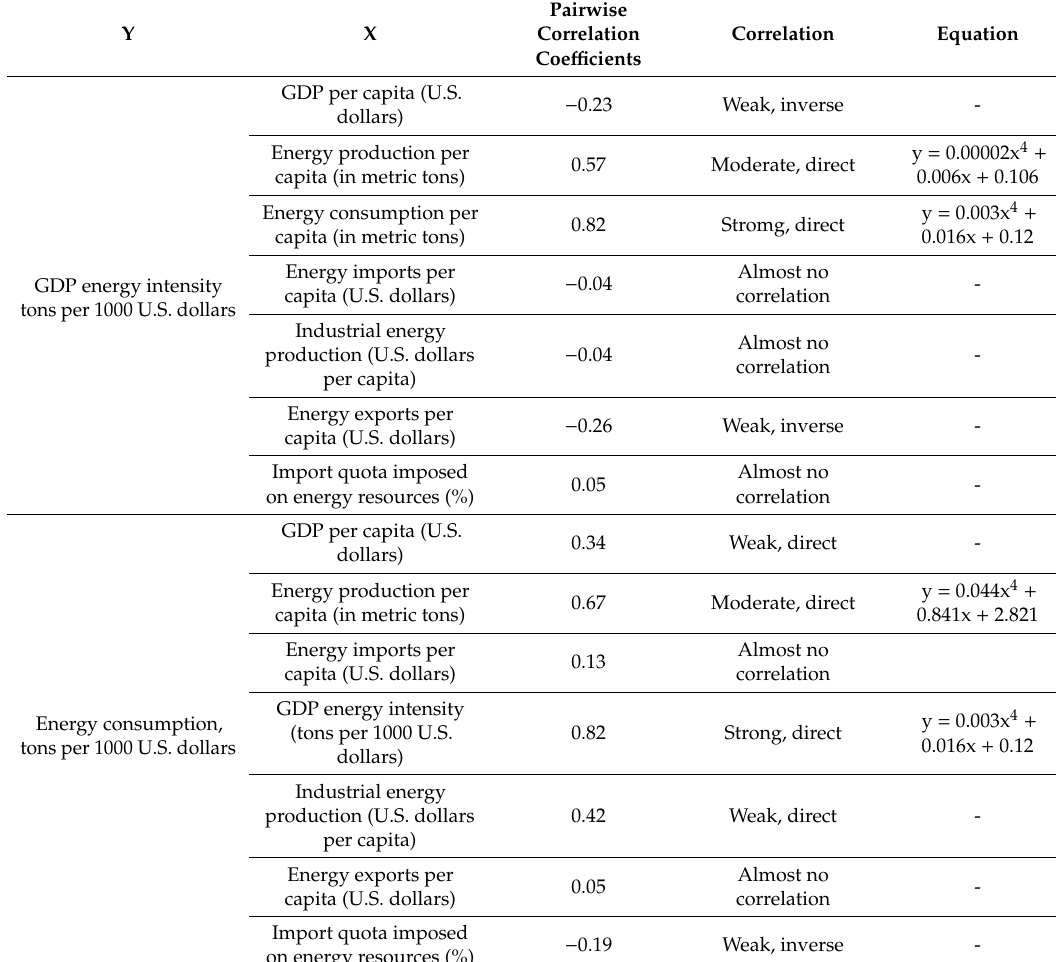
Table 1. Pairwise correlation coe ffi cients describing the relationship between the GDP energy intensity, energy consumption, and other factors under study. Y